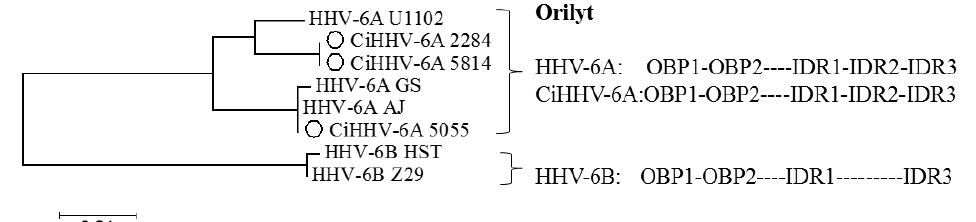
Figure 7. Phylogenetic analyses of the origin of lytic replication, ori-lyt in CiHHV-6A compared to HHV-6A. Replication origins from CiHHV-6A are compared to the maximally efficient ori-lyt mori region characterized by in vitro replication assays for HHV-6A strain U1102 [58]. HHV-6B ori-lyts are used as outgroups. The two origin binding motifs are conserved, OBP1 and OBP2 as are the indirect repeat regions, 1–3 (IDR1, IDR2, and IDR3). 100% bootstrap support for 1000 iterations at main nodes. Alignment is in Figure S2.